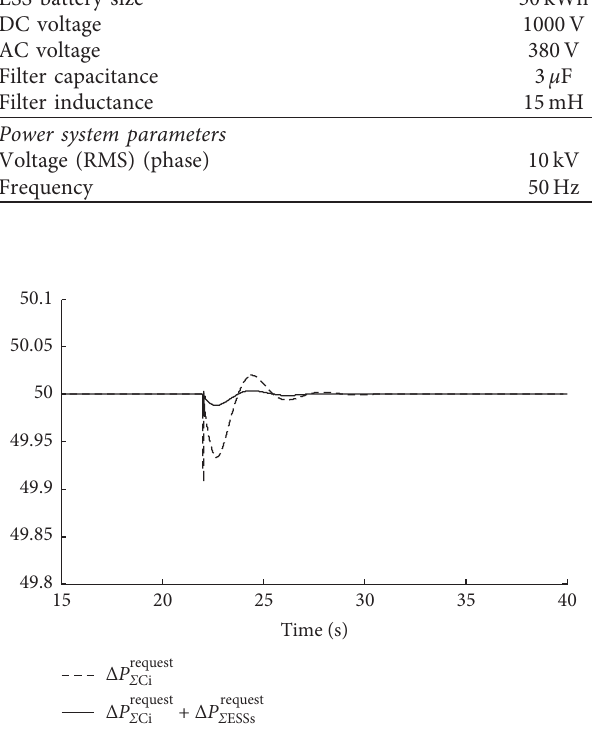
Figure 7: The 10kV power system frequency.